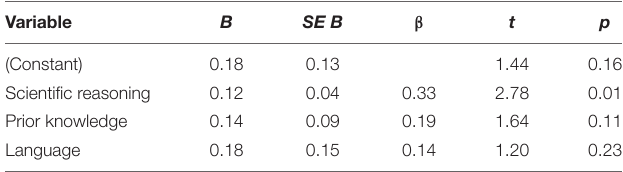
TABLE 10 | Regression analysis summary for scientific reasoning, prior knowledge, and language predicting general epistemic activities in observation competency.